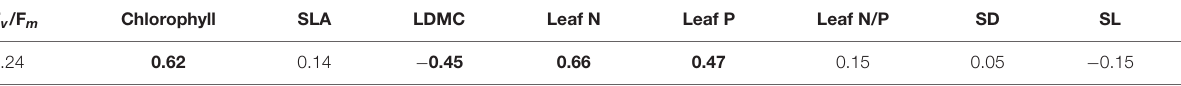
TABLE 5 | Pearson’s correlation coefficients between production and foliar traits calculated across all species in the four treatments ( n = 42).